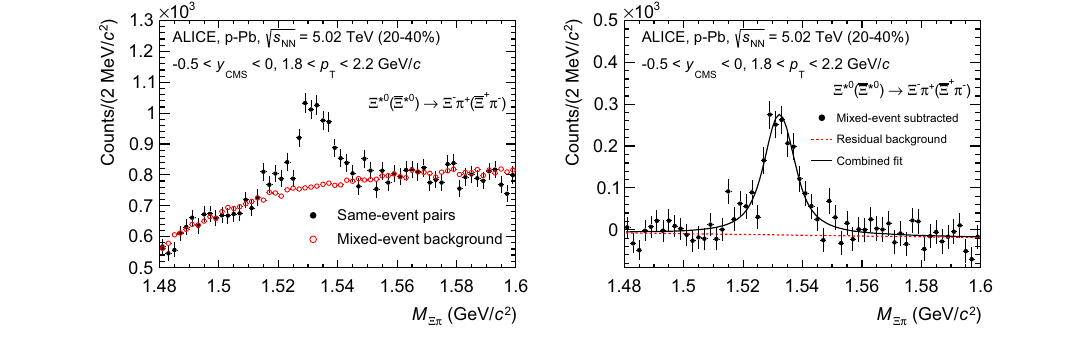
1 . 49 < M (cid:4)π < 1 . 51 GeV / c 2 and 1 . 56 < M (cid:4)π < 1 . 58 GeV / c 2 . ( Right ) the invariant mass distribution after subtraction of the mixed- event background. The solid curve represents the combined fit, while the dashed line describes the residual